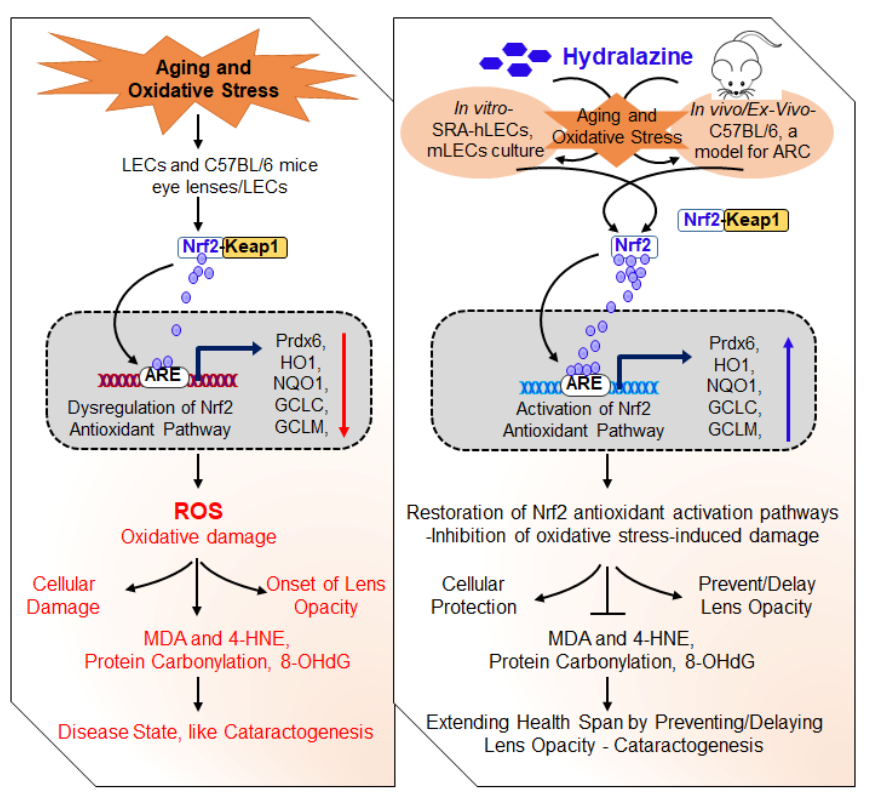
Figure 13. ( Left panel ) Schematic illustration displaying the effects of oxidative stress/aging on the dysregulation of Nrf2 pathways and their consequences at molecular and cellular levels. Aging lenses/LECs or lenses/LECs facing oxidative stress bear reduced levels of antioxidant expression due to dysregulated Nrf2 antioxidant pathways, which cause increased ROS and oxidative damage. Increased ROS levels result in the oxidative-driven lipid, protein, DNA, and cellular damage and in turn lead to lens opacity/cataracts (a disease state). ( Right panel ) Illustration of the molecular mech- anism(s) of Hyd-mediated restoration of dysregulated the Nrf2-dependent antioxidant protective pathway, thereby leading to cellular protection and extension of lens healthspan and prevention of lens opacity in response to oxidative stress, in vitro and in vivo/ex vivo . Hereby, we propose that blinding diseases related to oxidative stress or aging can be delayed or prevented by means of Nrf2 activators, such as Hyd.